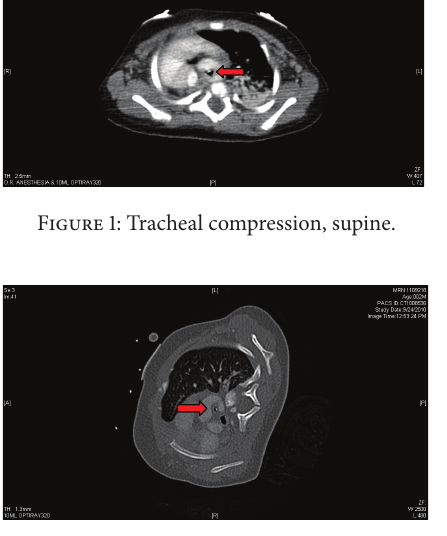
Figure 2: Further airway compression,